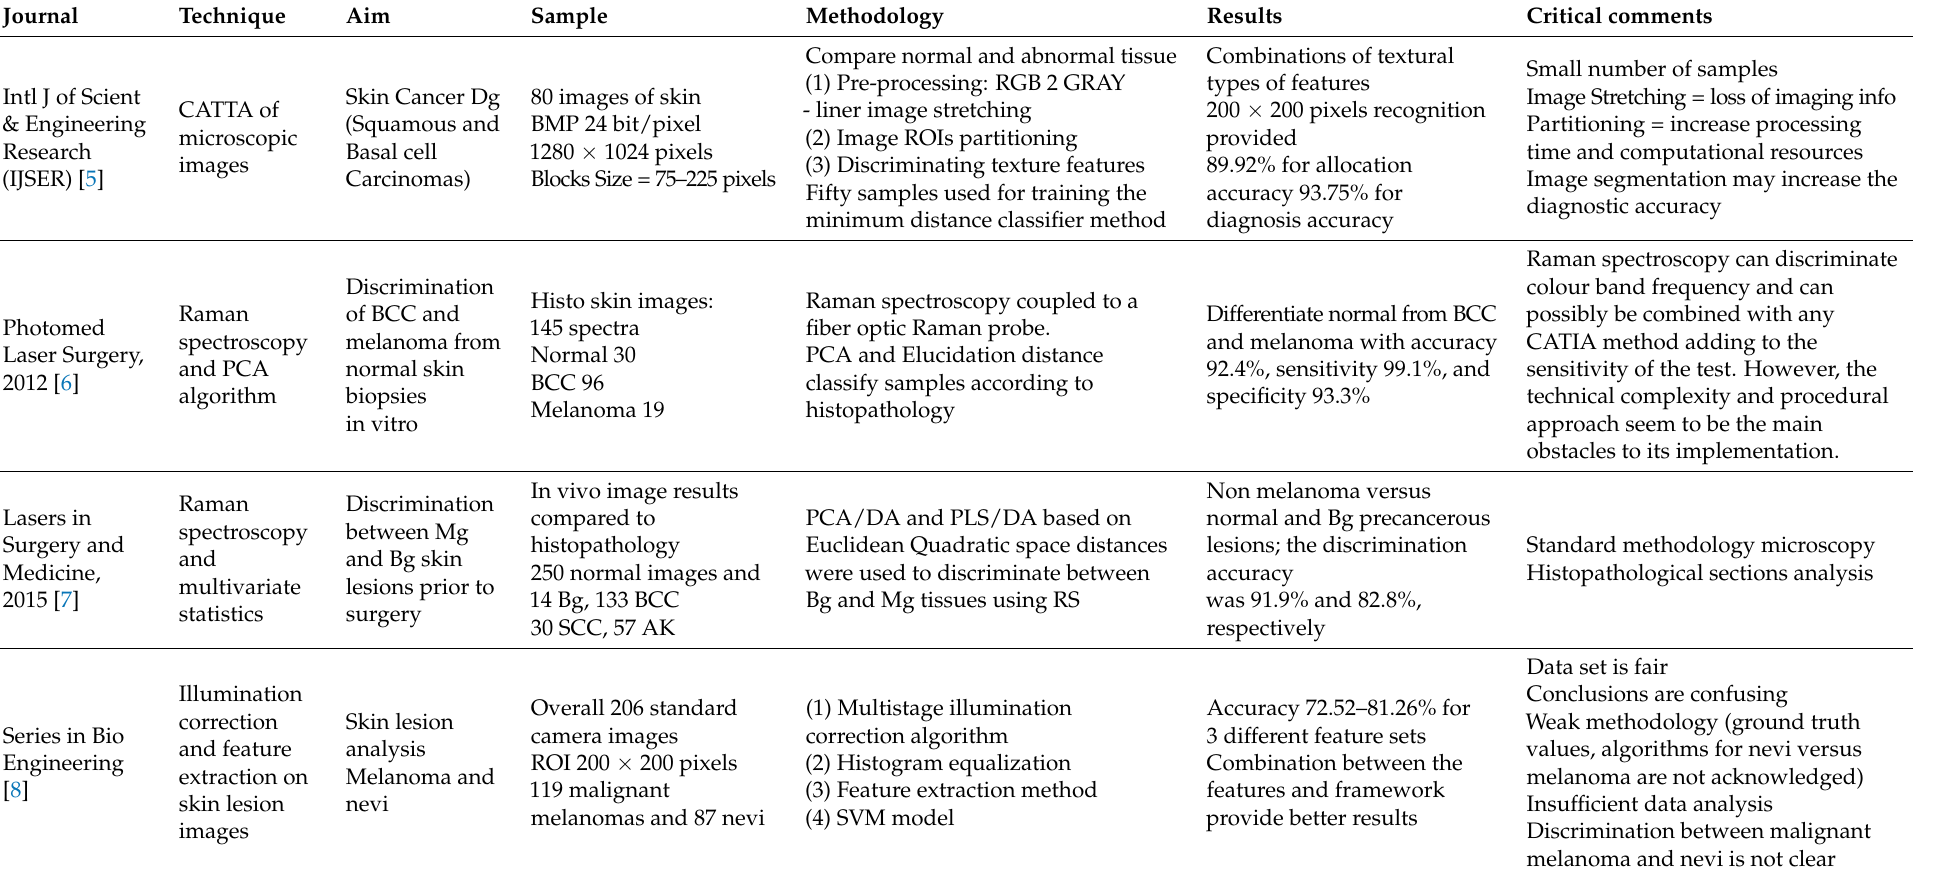
Table 2. Imaging process evaluating normal and abnormal tissue for dermatological